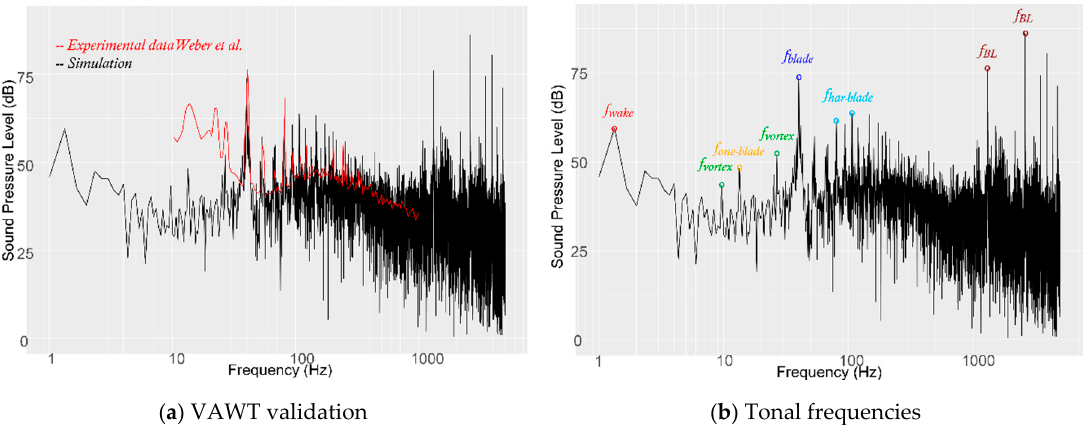
Figure 5. Sound Pressure Level for an isolated VAWT: ( a ) Comparison of experimental (red) [23] and our LES + FWH simulations (black), and ( b ) Annotated version highlighting the main physical frequencies in the VAWT.